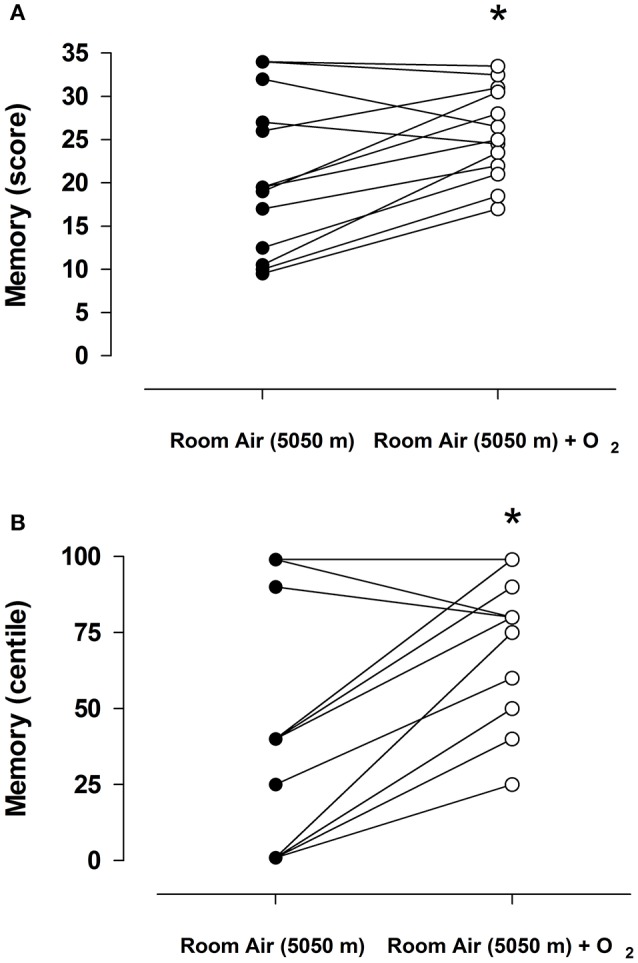
Individual response to the Rey-Osterrieth Complex Figure (memory) in 13 subjects breathing room air of 5,050 m (open circles) and room air of 5,050 m enriched with oxygen (closed circles). (A) Represent absolute score obtained of each subject in both condition, and (B) represent values expressed in centile. The lines represent the mean ± SD, asterisk p < 0.001.